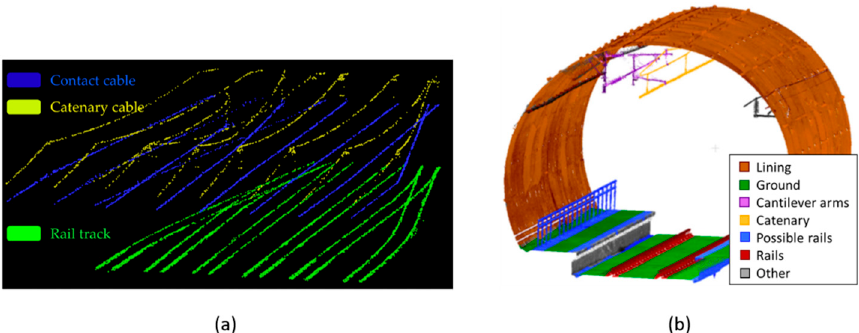
Figure 8. Inventory and 3D modelling.( a ) Arastounia et al. [134] classified rail tracks and